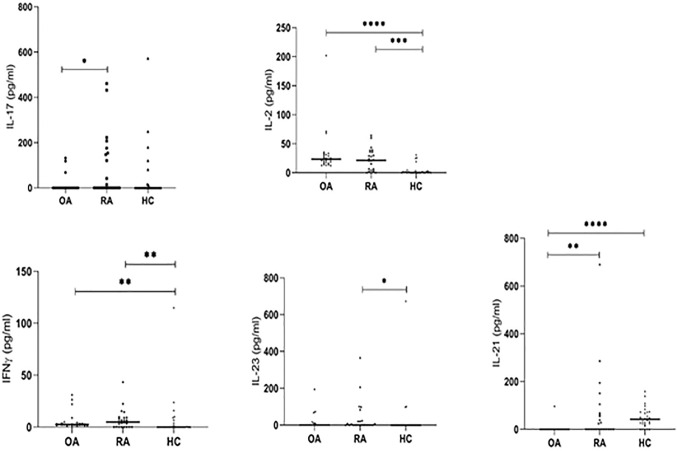
The serum IL-17, IL-21, IL-2, IL-23, IFN-γ levels detected by ELISA. *p < 0.05, **p < 0.01, ***p < 0.001, ****p < 0.0001.